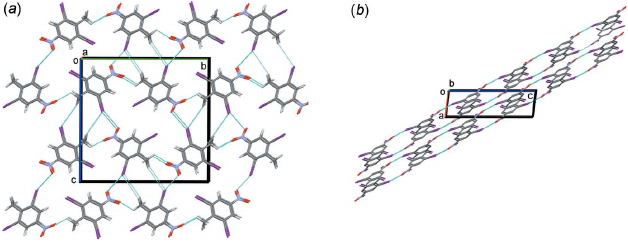
Figure 4 A view along the a and b axes of the crystal packing of